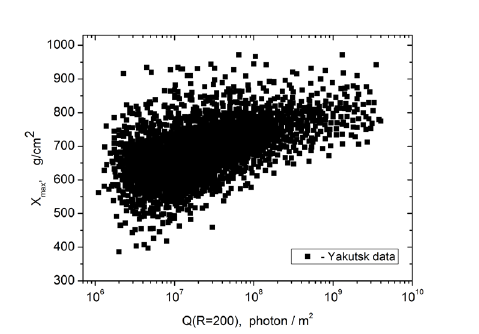
Figure 4. Dependence of the muon fraction on depth of maxi- mum development of electron-photon cascade of air showers at zenith angles θ 1 = 18 ◦ , θ 2 = 38 ◦ and θ 3 = 58 ◦ . The fits are made